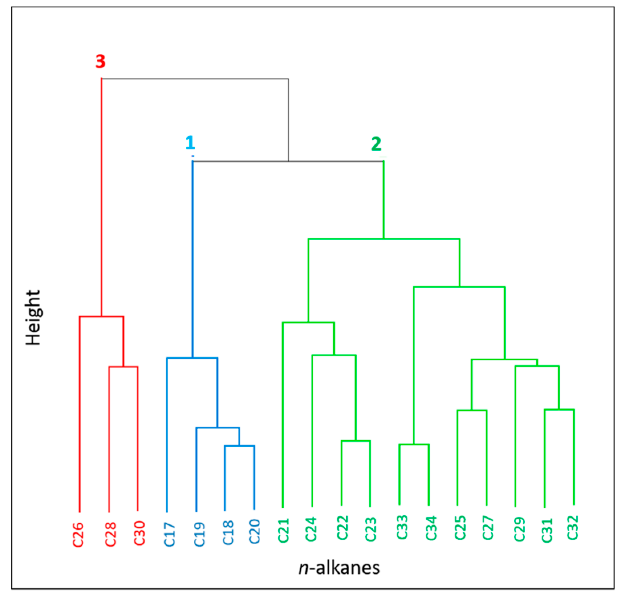
Figure 6. Cluster analysis for all sampling sites.